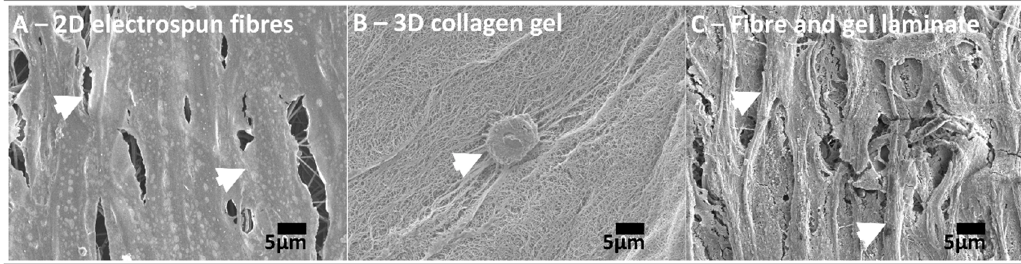
Figure 1. Scanning Electron Microscope (SEM) images: ( A ) flattened, elongated fibroblasts on electrospun fibres, ( B ) rounded fibroblast within a collagen hydrogel, ( C ) rounded and elongated fibroblasts on electrospun fibre/hydrogel composite (gel removed for imaging). Scale = 5 µ m, arrows indicate position of cells.